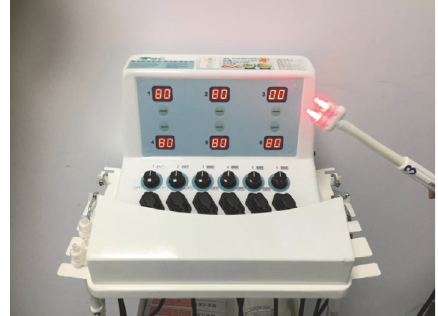
Figure 1: Transverse Many Channels Laser Instrument (Transverse, Ind, Co., Ltd., Taipei, Taiwan).